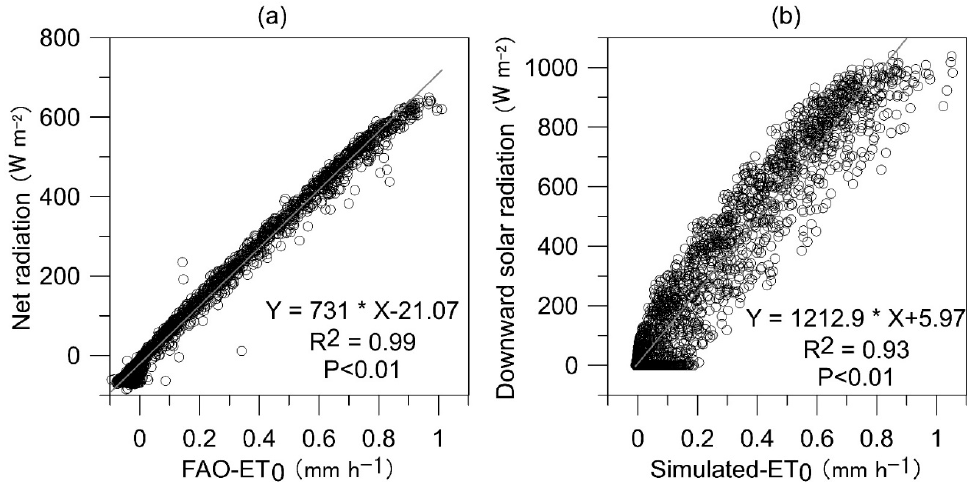
Figure 5. Relationship between downward solar radiation and reference evapotranspiration (ET 0 ) simulated by ( a ) the Penman–Monteith method by the Food and Agriculture Organization (FAO-PM) and ( b ) the reference soil–plant–atmosphere continuum (R-SPAC) model.